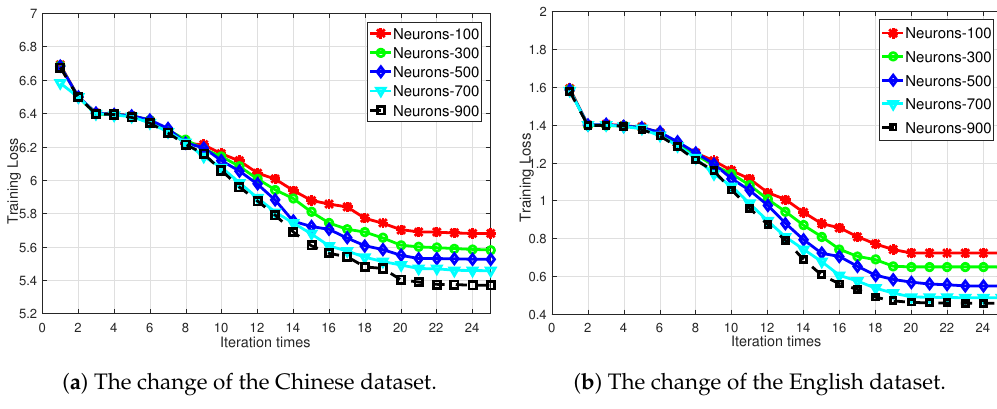
Figure 8. Training loss curve along with the change of the number of neurons.